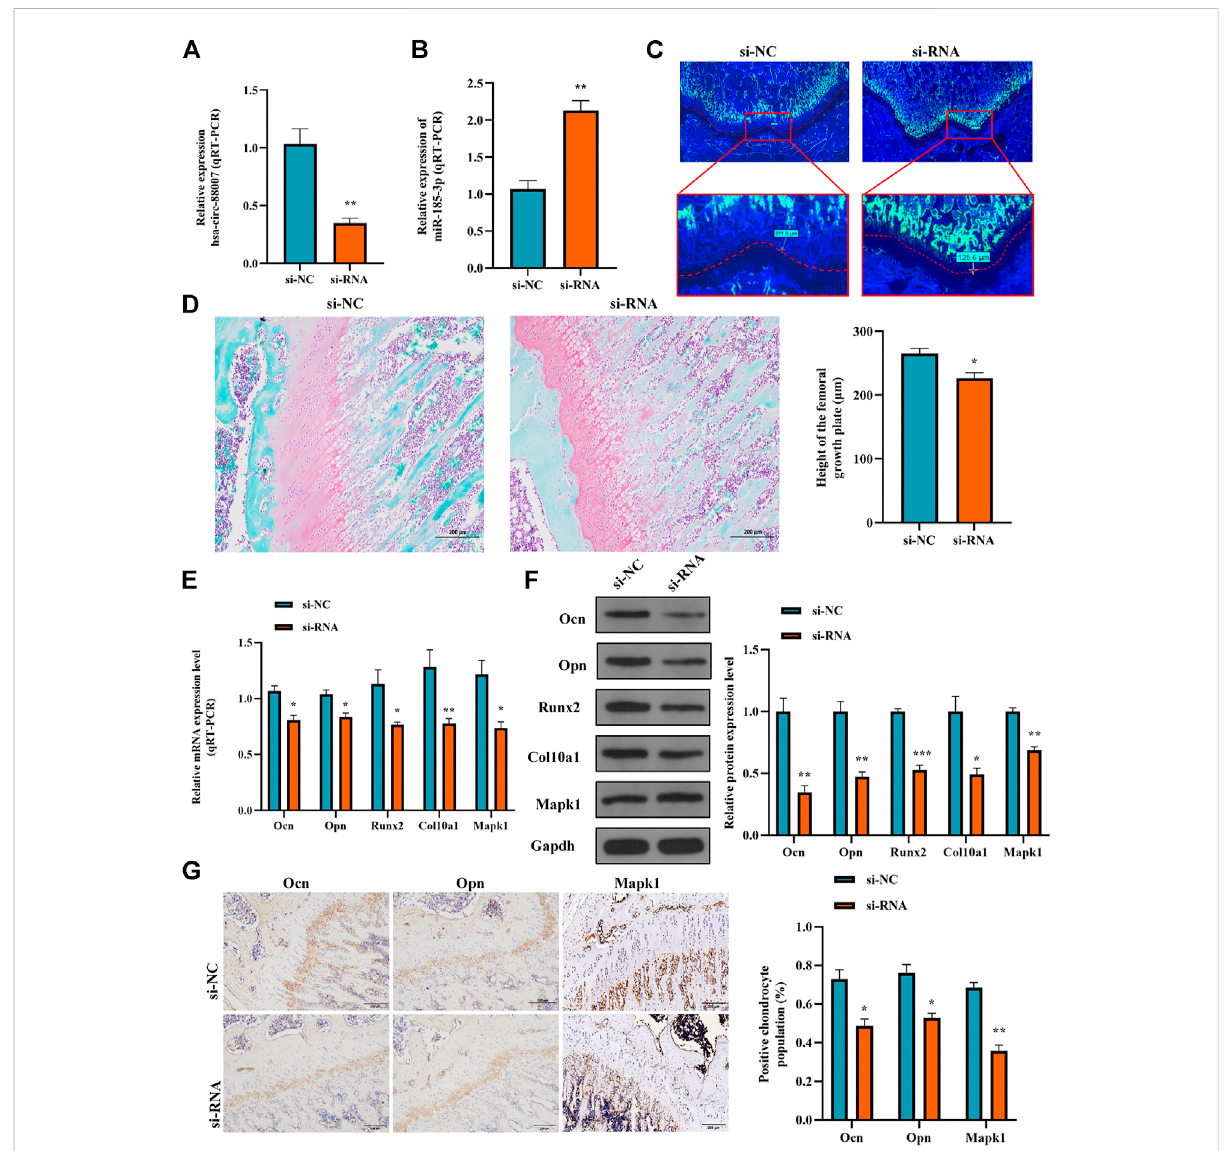
FIGURE 11 Hsa_circ_0008870/miR-185-3p/MAPK1 axis inhibits endochondral osteogenesis as well as the hypertrophy, proliferation and growth of chondrocytes in vivo . (A,B) The RNA levels of hsa_circ_0008870 and miR-185-3p in rats injected with si-circ-0008870 or normal control lentivirus were measured by RT-qPCR. (C) Analysis of the new bone formation rate in the rats by calcein labeling. (D) Assessment of the height of the femoral Growth plate in rats by Safranin O staining. (E,F) The mRNA and protein expressions of Ocn, Opn, Runx2, collagen type X and Mapk1 were detected byRT-qPCR. (G) Expression levels of Ocn,Opnand Mapk1inrat growth plates wereanalyzed by immunohistochemical staining.* p < 0.05, ** p < 0.01 and *** p <